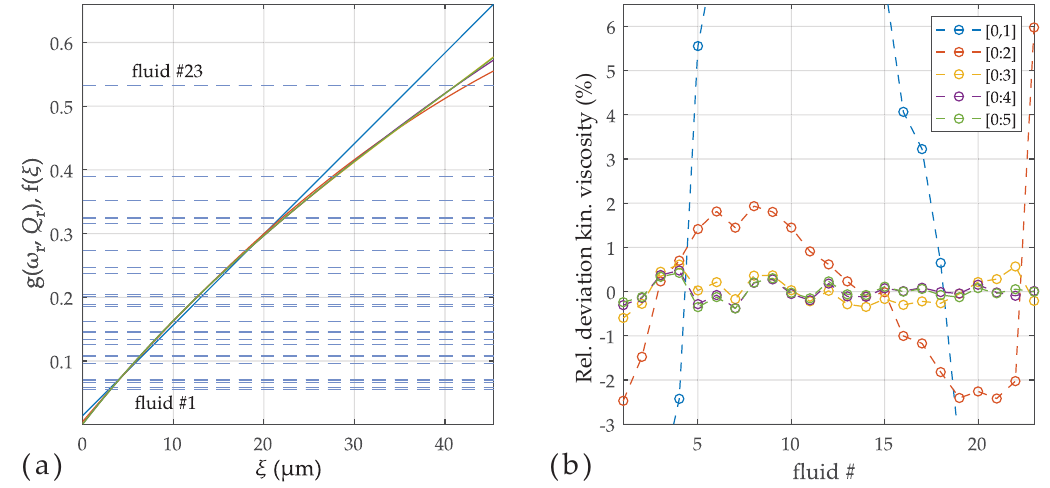
Figure 8. ( a ) The solutions ξ ∗ are determined by the intersections of g ( ω r , Q r ) (dashed lines) and f ( ξ ) (solid lines). f ( ξ ) is shown for different polynomial orders, where all fluids were used for calibration. ( b ) The relative deviations between the reference ( ν ) and estimated (ˆ ν ) kinematic viscosities decrease with increased order, but do not improve noticeably above an order of 4. The cut-off extreme deviations for first order are + 10% and −